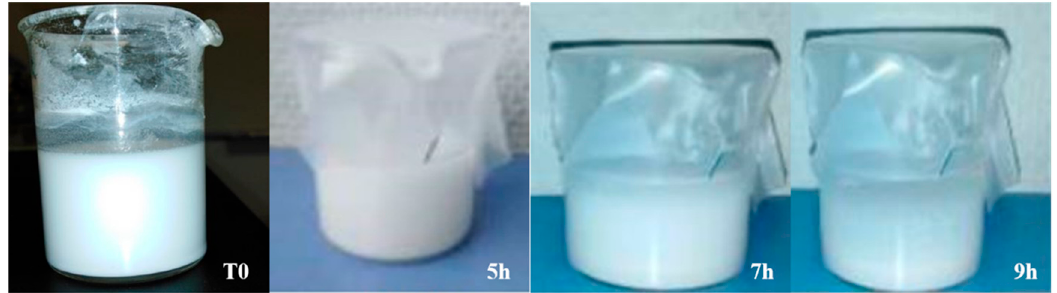
Figure 8. Suspension stability study of the 4 wt% suspension prepared in isopropanol.